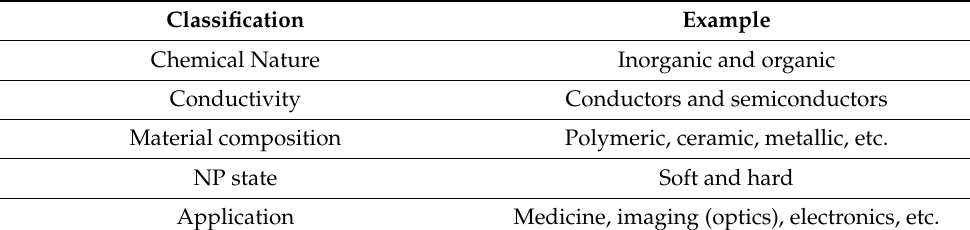
Table 3. Classification of Nanoparticles. Classification Example Chemical Nature Inorganic and organic